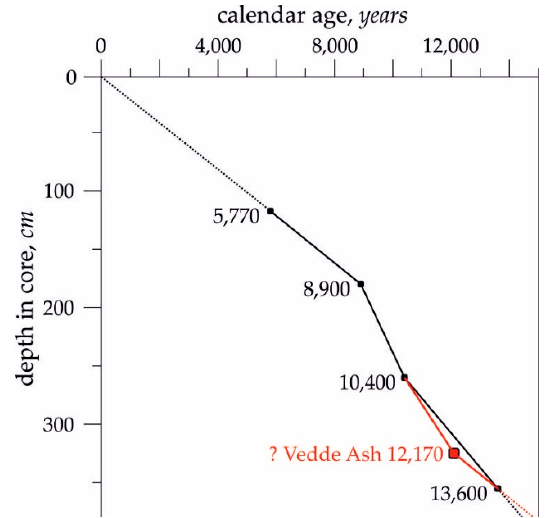
Figure 11. Corrected age-depth plot for the Termination I interval of the core AMK-340 (red line) according to the occurrence of Vedde Ash in the sample of 323–325 cm (black-outlined red square). Black squares and black captions on the plot show the radiocarbon datings converted to calendar dates (see also Figure 2).